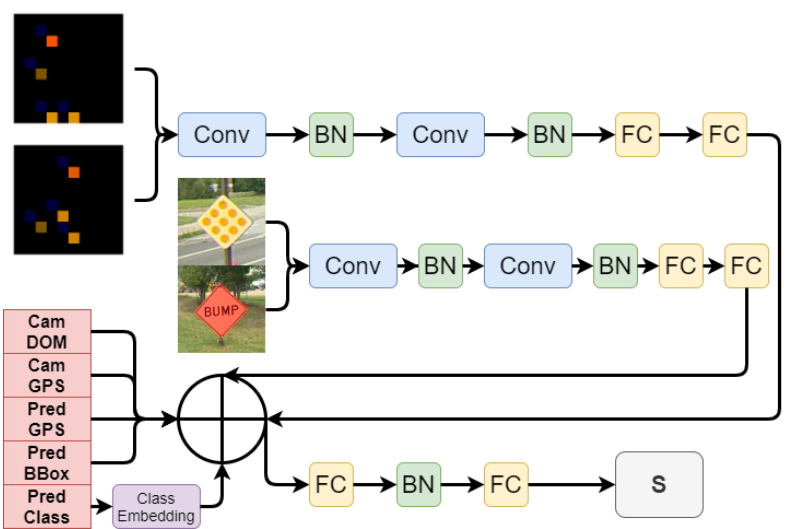
Figure 9. The architecture of the similarity network. The network uses two siamese sub-networks and then concatenates all the resulting features. The remaining features are sent through two more fully connected layers before predicting the similarity